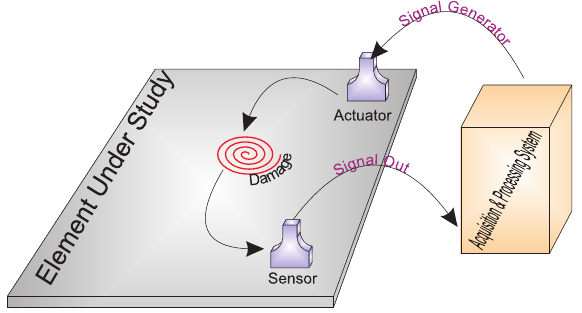
Figure 7. General scheme of the SHM